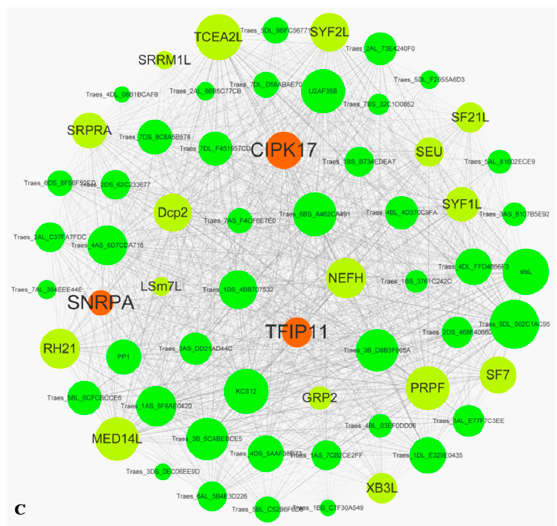
Figure 5. Construction of Pst-induced specific gene modules and networks. ( A ). Heat map and eigengene expression profile for the skyblue2 (24 hpi) module in leaves of Pst -inoculated wheat resistance line N9134. The y-axis indicates the value of the module eigengene; the x-axis indicates sample type. The letter P and S in X-axis referred to the Bgt and Pst stress respectively, while R showed the replications. Heat map shows the relative FPKM of each gene. ( B ). The top 20 KEGG pathway enrichment categories of differentially expressed genes (DEGs) in skyblue2 module. The KEGG pathways are listed on the left, while Q-values and gene numbers are shown on the right. ( C ). The correlation network of the skyblue2 module. Sixty-six genes with edge weight >0.1 are visualized using Cytoscape_v.3.0.0. Twenty-three genes related to spliceosome components or transcription-related regulators are marked with abbreviated gene names, while the others were marked with URGI gene numbers. The diameter of the circles is proportional to connectivity.